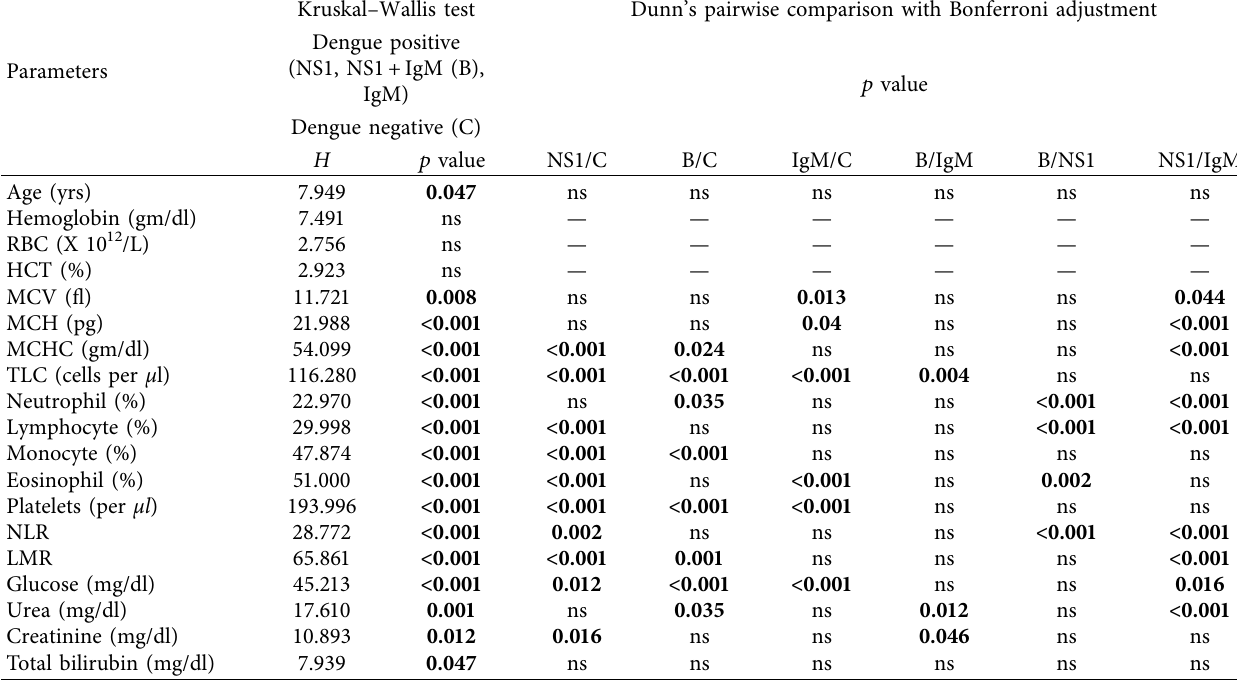
Table 3: Kruskal–Wallis test and the post hoc Dunn’s pairwise analysis with Bonferroni adjustment among the dengue negative group and NS1 positive, IgM positive, and both NS1+ IgM positive dengue